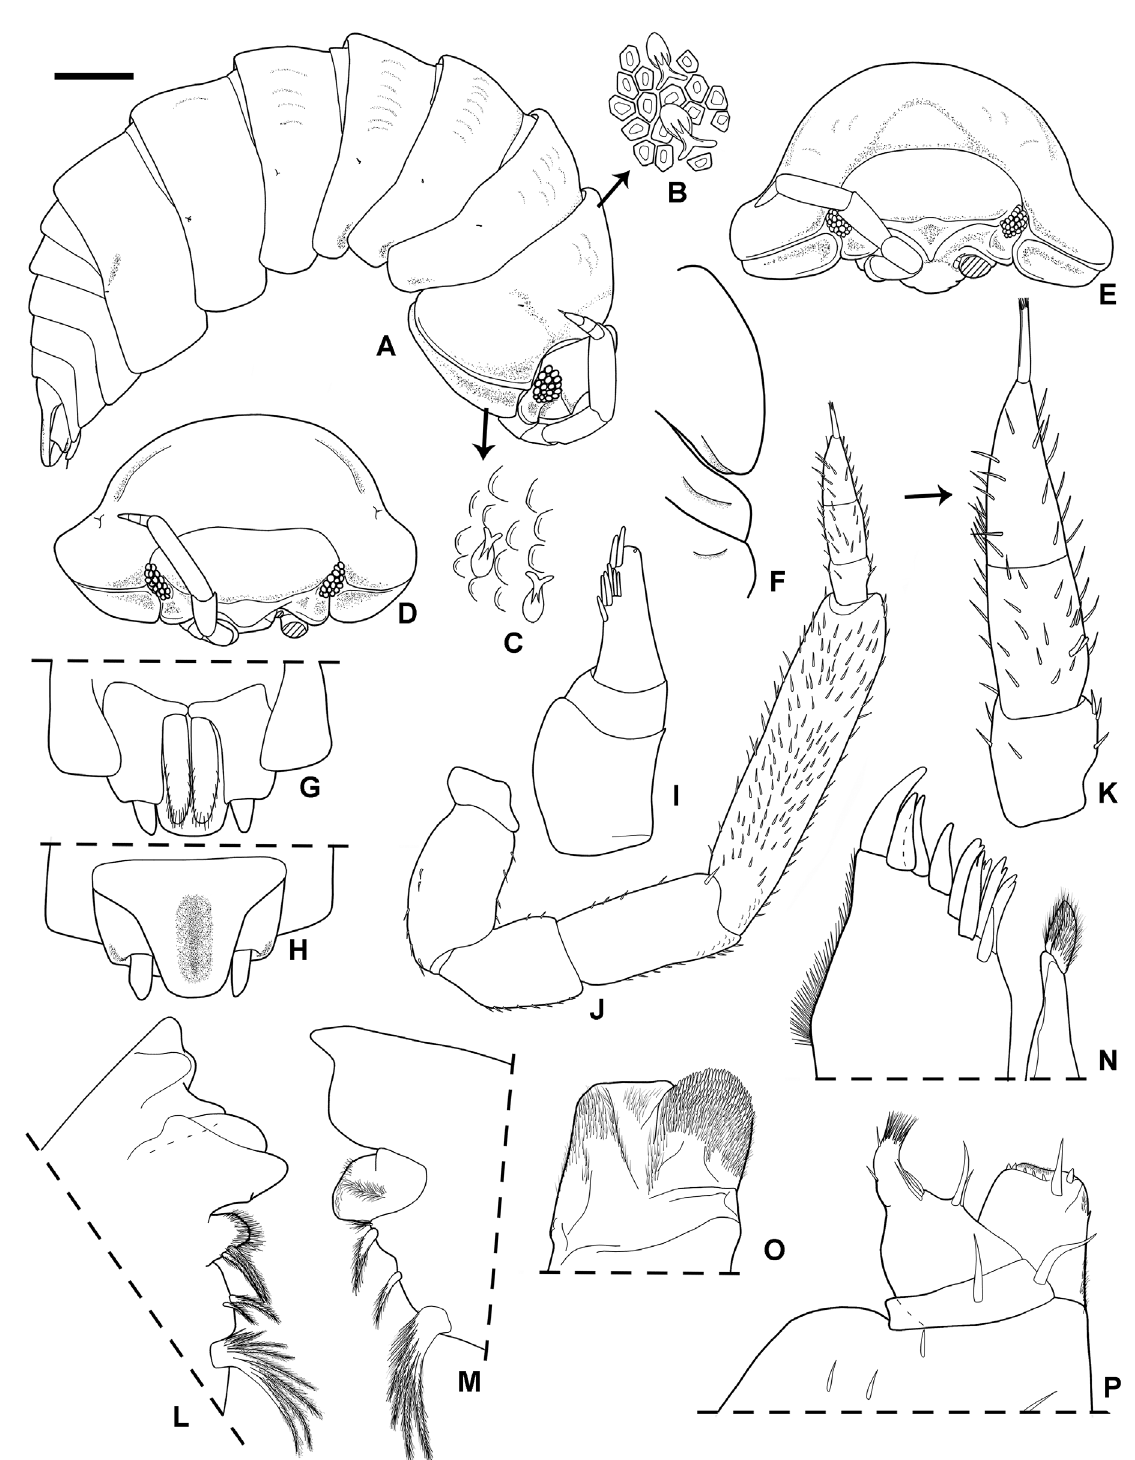
Fig. 1. Brasiloniscus maculatus (Lemos de Castro, 1973) gen. et comb. nov., paratype, ♂ (MNRJ 6212). A . Habitus, lateral view. B . Details of dorsal scales, setae and polygonal pattern scales. C . Details of overlapping scale setae on schisma. D . Cephalon and pereonite 1, dorsal view. E . Cephalon and pereonite 1, frontal view. F . Pereonites 1–3, ventral view. G . Pleonite 5, telson and uropods, ventral view. H . Pleonite 5, telson and uropods, dorsal view. I . Antennula. J . Antenna. K . Antennal flagellum. L . Left mandible. M . Right mandible. N . Maxillula. O . Maxilla. P . Maxilliped. Scale bar: 1